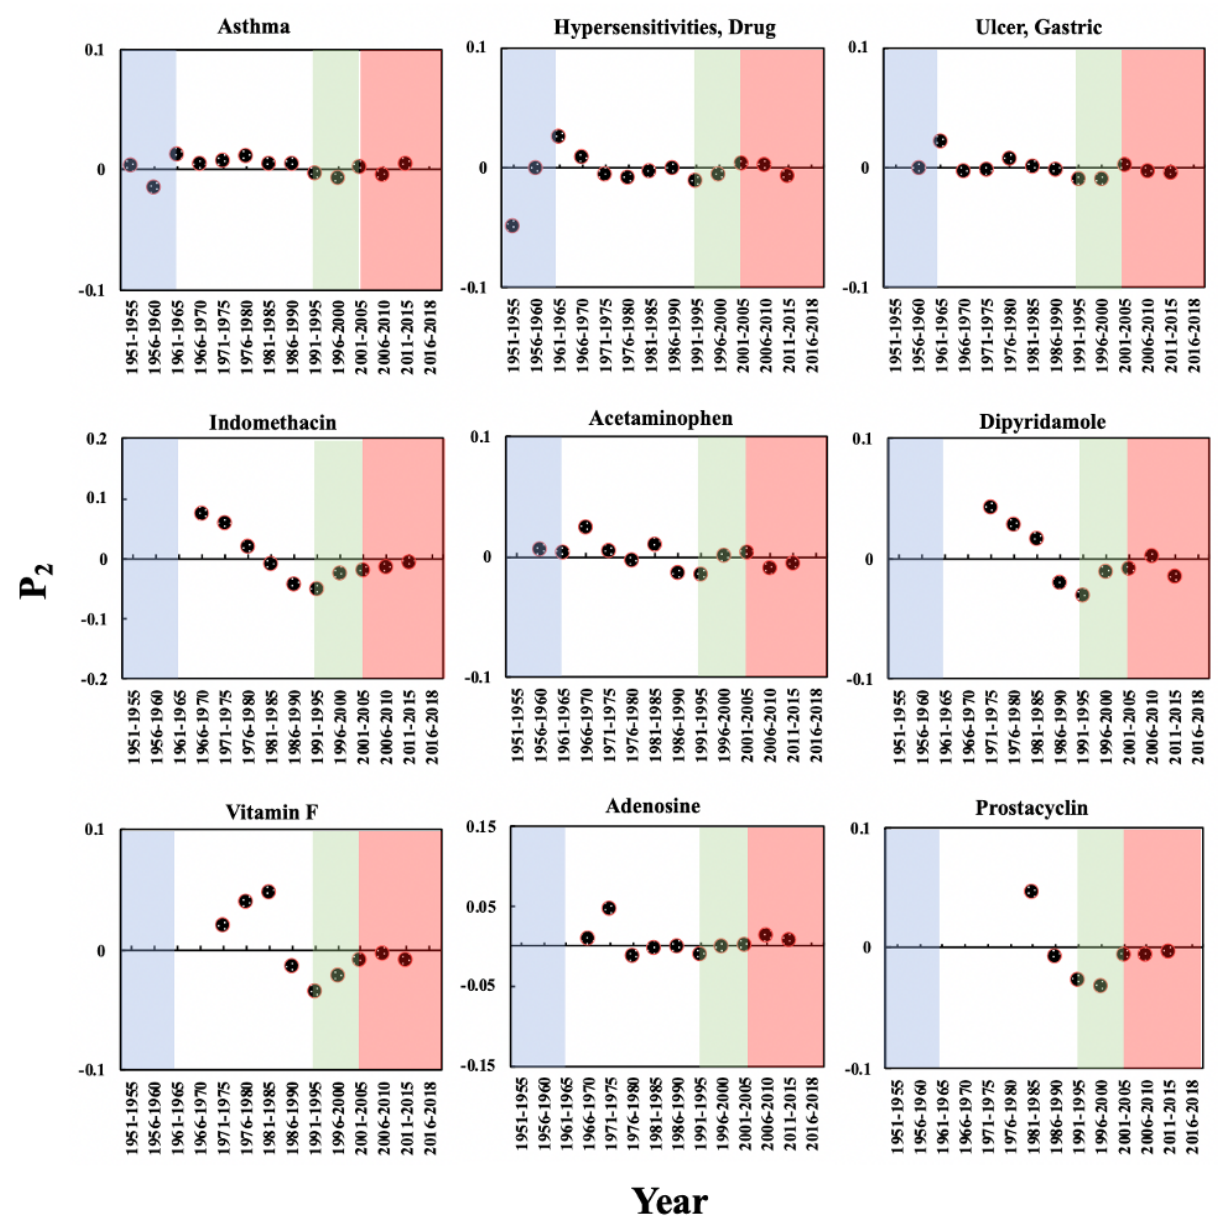
Figure 4. The Promising Index (P 2 ) of the biomedical entities on the pharmacological mechanisms and side effects of aspirin over time. The background colors show the 4 phases of aspirin